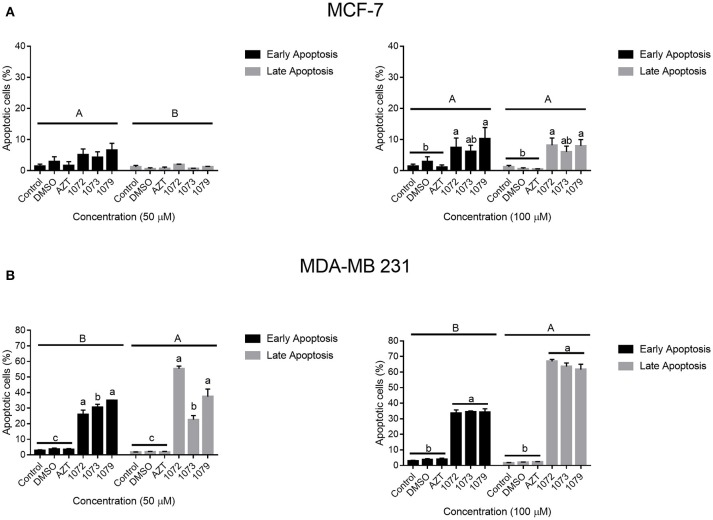
Induction of apoptosis by AZT and derivatives. MCF-7 and MDA-MB 231 cells treated with AZT and derivatives were examined for apoptosis by 7-AAD and Annexin V-PE staining. The graph shows the percentage of cells in early apoptosis (marked only with Annexin V-PE) and late apoptosis or dead (marked with V-PE e 7-AAD). Significant differences were considered at P < 0.05. Different capital letters indicate significant differences between stages of apoptosis. Different lowercase indicate significant differences between different treatments.